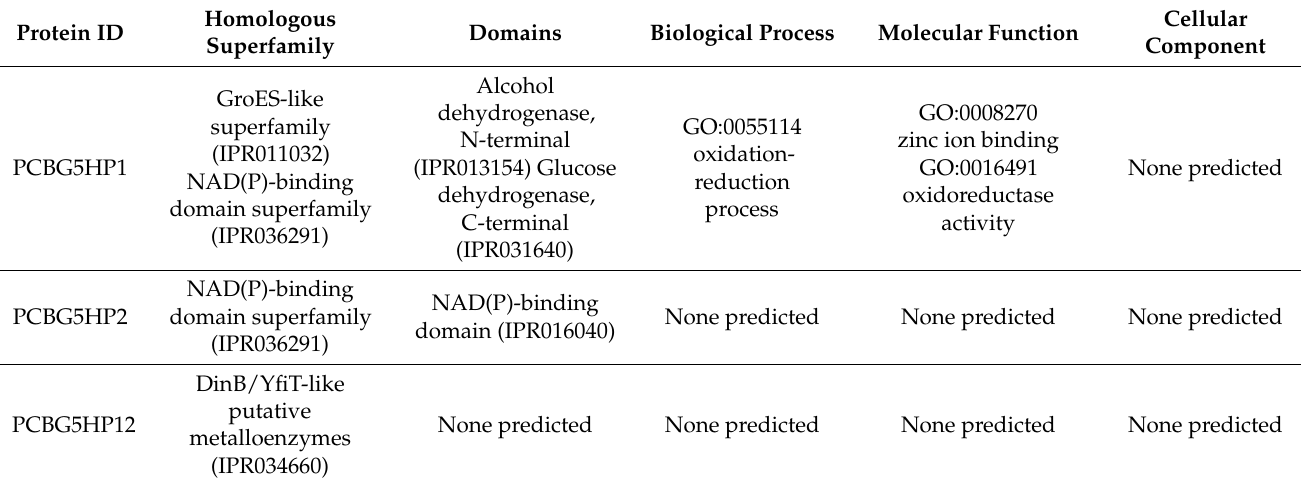
Table 4. Functional annotation of P. cryoconitis HPs by the InterProScan